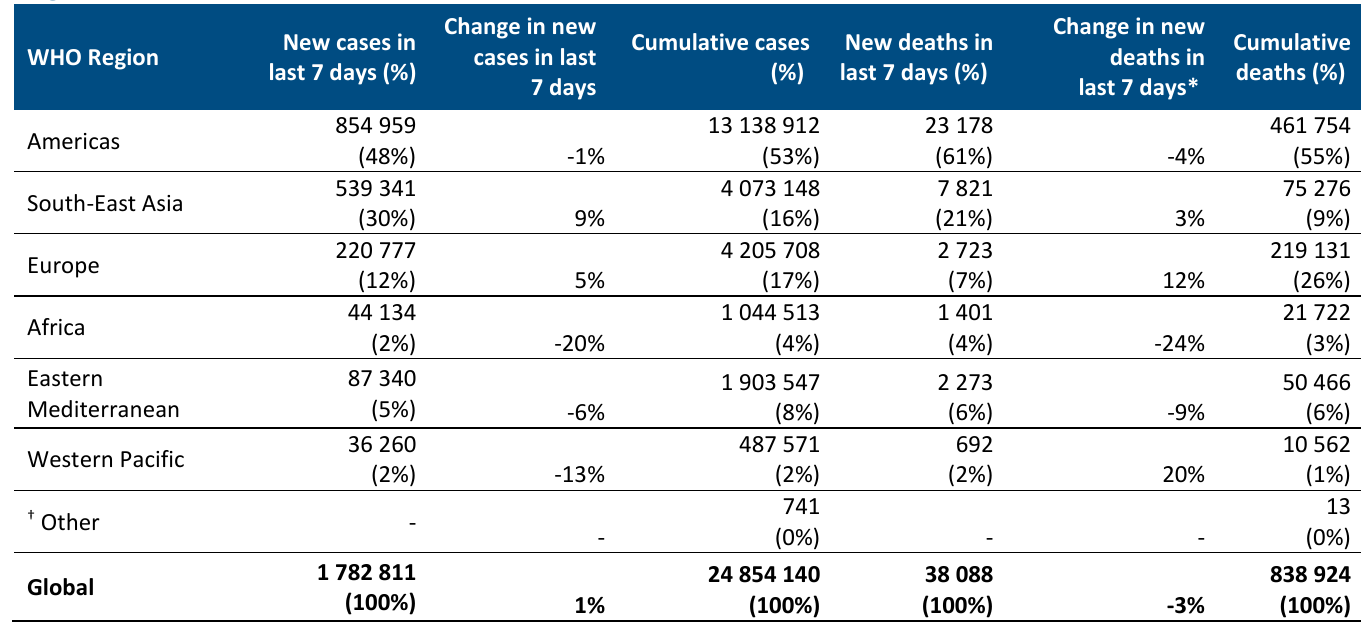
Table 1. Newly reported and cumulative COVID-19 confirmed cases and deaths, by WHO Region, data as of